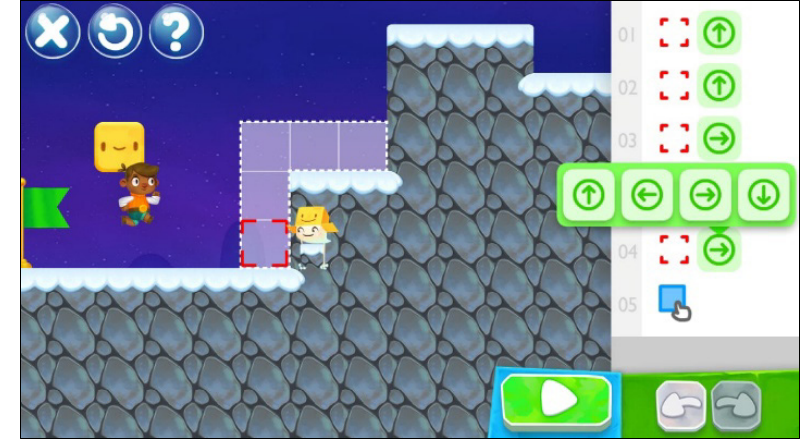
Fig. 5. Interface with the Spritebox game in